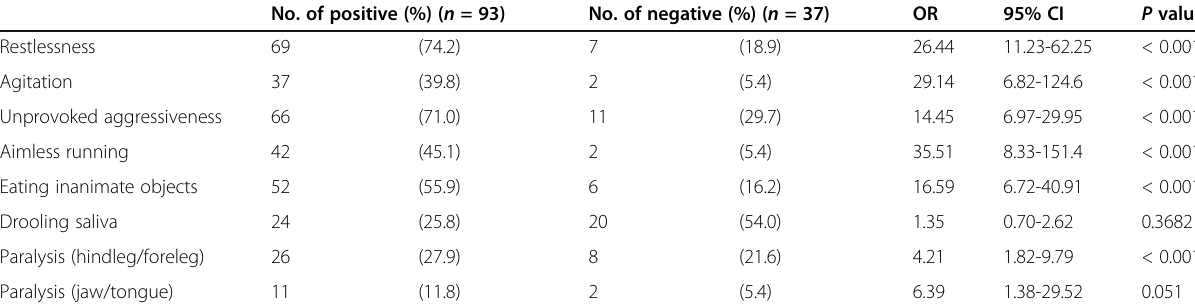
Table 3 Logistic regression model for clinical characteristics associated rabies suspected animals No. of positive (%) ( n =